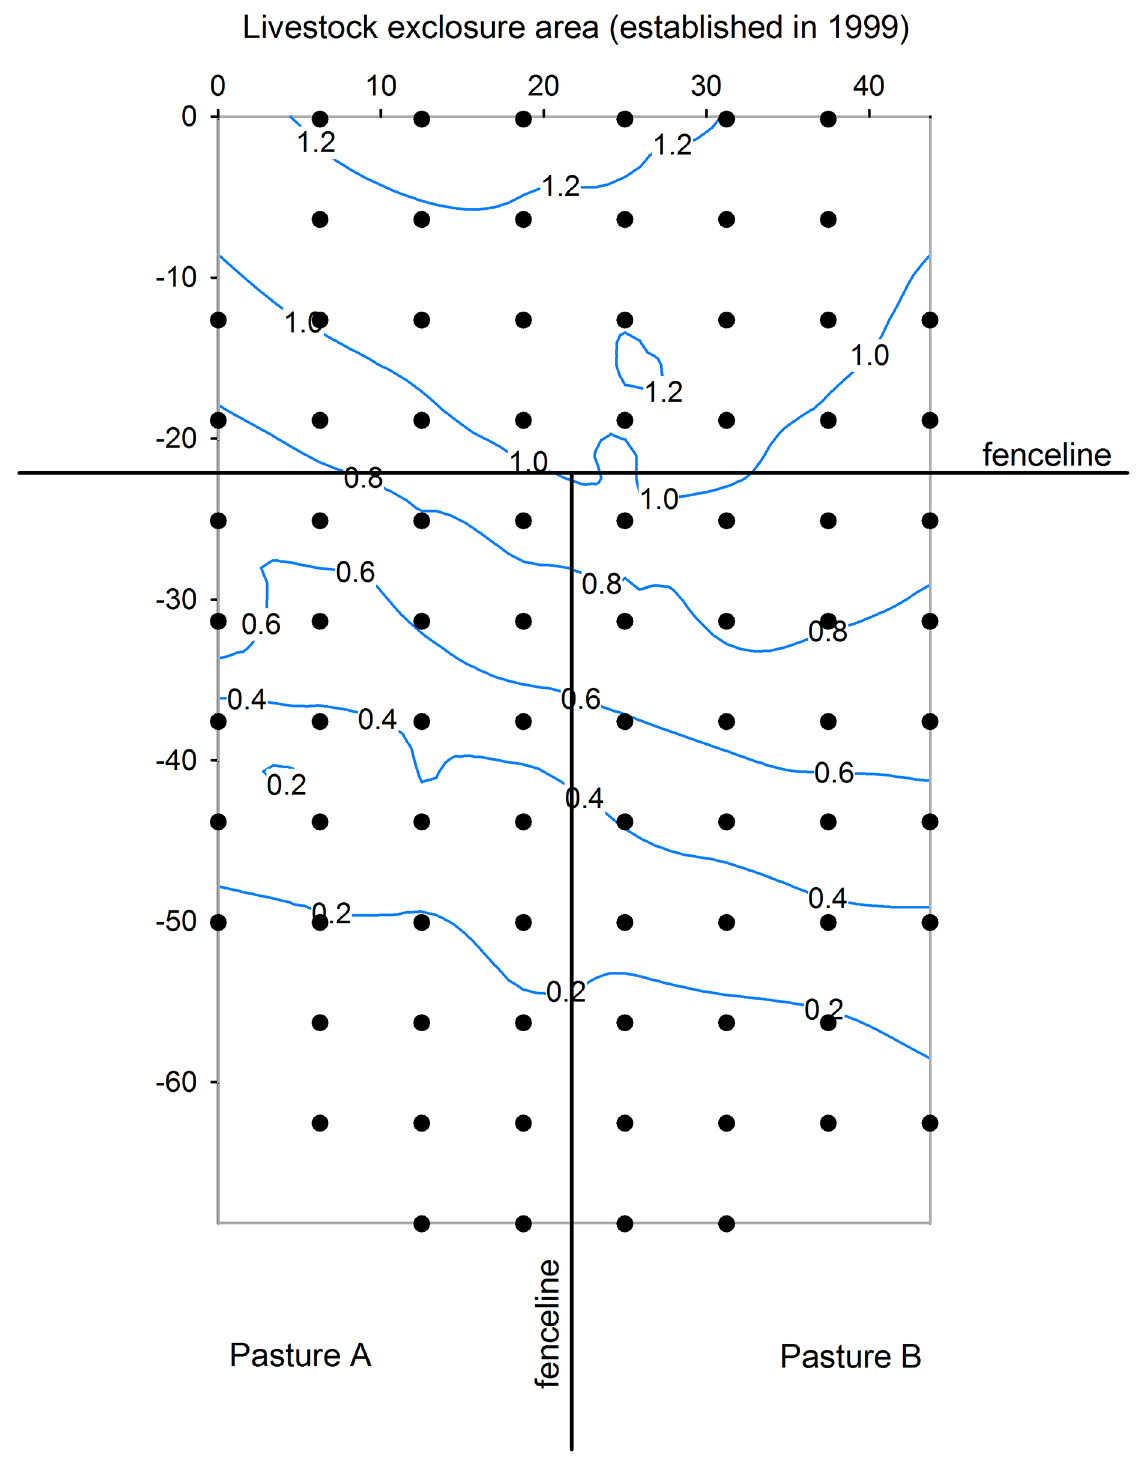
Fig 1. Map of the sampling area (0.3 ha). Sampling was divided equally among three adjacent areas: a livestock exclosure and two adjacent pastures (A, B) grazed annually by cows. Individual sampling points are shown ( ● ), axes ’ units are meters, and contour lines represent elevation gain (m) relative to the lowest point in the sampled